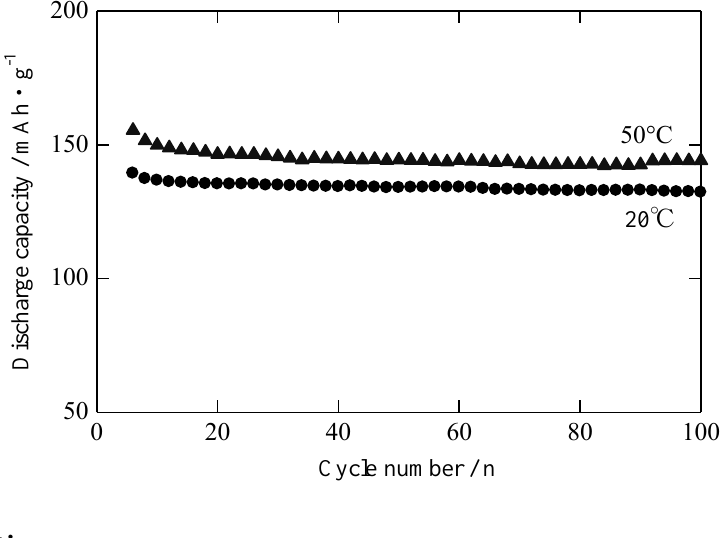
Figure 8. Cycle stability of RLTO anode material at 25  C and 50 